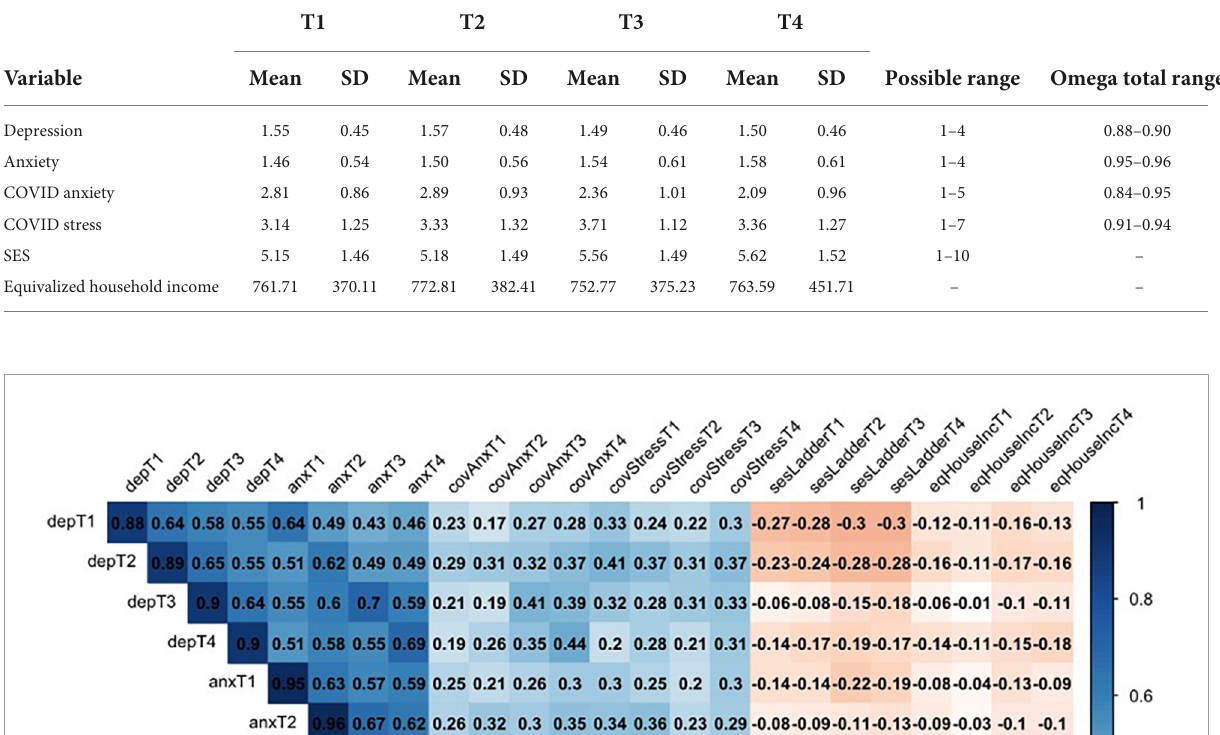
TABLE 2 Descriptive statistics and reliabilities.